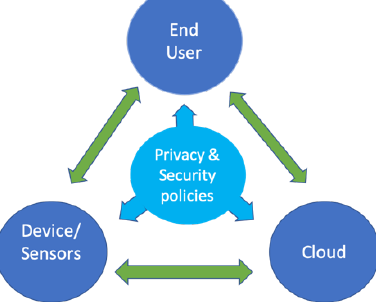
Figure 1. Internet of Things (IoT) generic model with privacy and security policies.